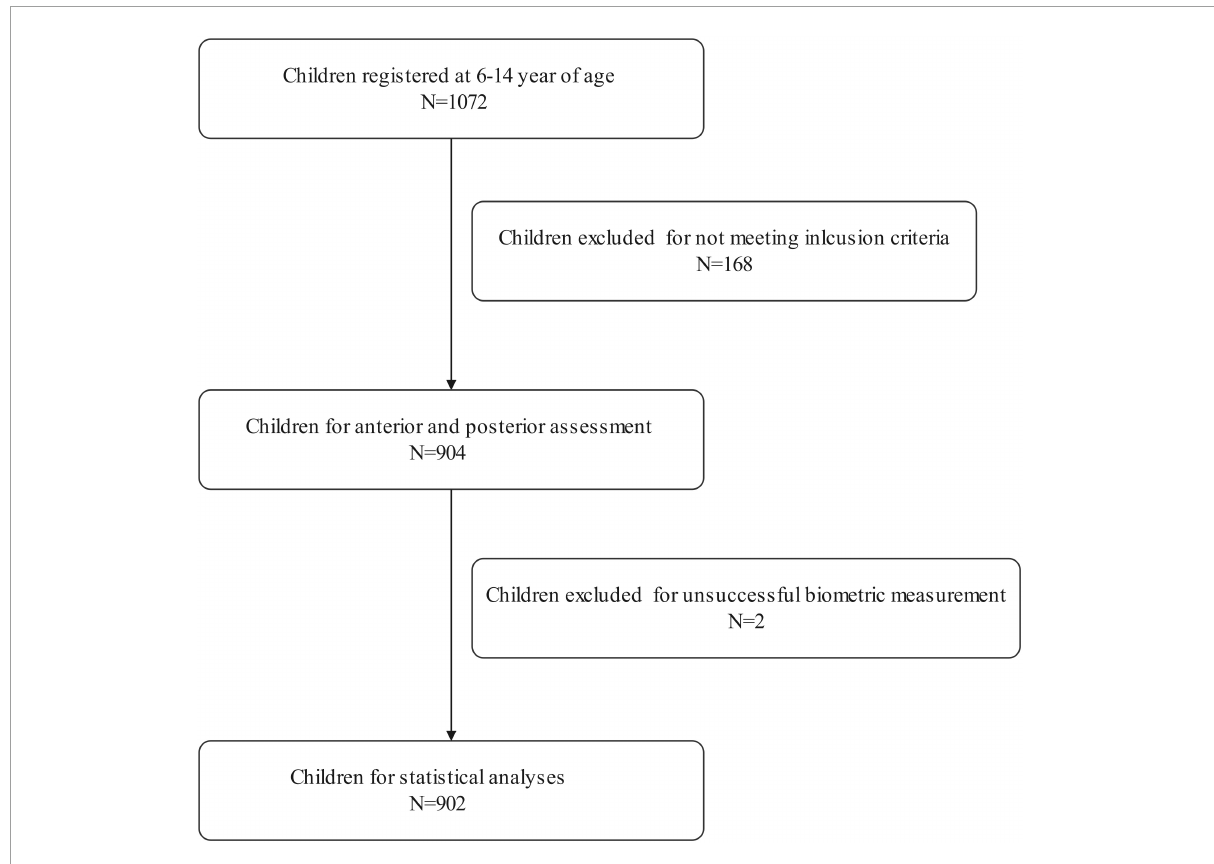
variance in SER was explained. About 51.1% of the variance in SER was explained, when AL/CCR was included in model 2. The AL/CCR ratio, along with LP was included in model 3, which explained 59.2% variance in SER ( Table 3 ). length and the AL of the eye. The active mechanism